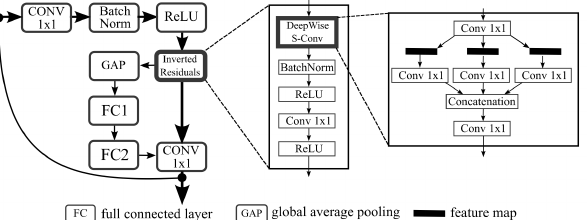
Figure 3. The overview of IR block. IR block implemented deepwise separable convolution and drew on the idea of the SENetalgorithm. DeepWise S-Conv represents a deepwise separable convolu- tion block.